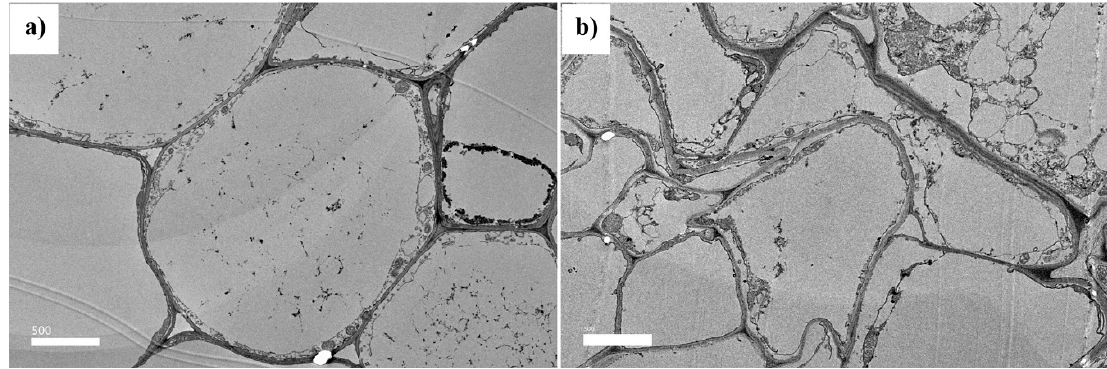
Figure 7. Transmission electron microscopy (TEM) micrograph (magnification = ×1500) of ( a ) control tissue and ( b ) Ni-loaded tissue.